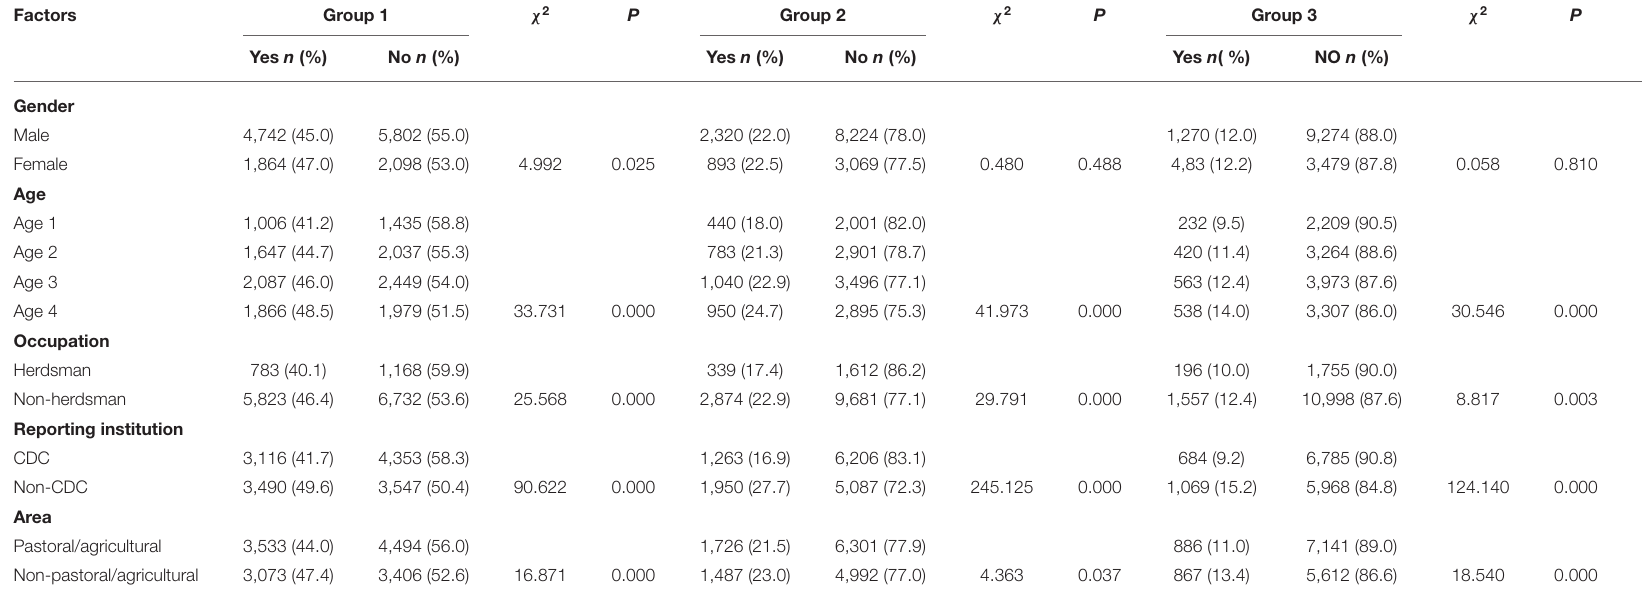
TABLE 2 | Univariate analysis of risk factors of the diagnostic delays in human